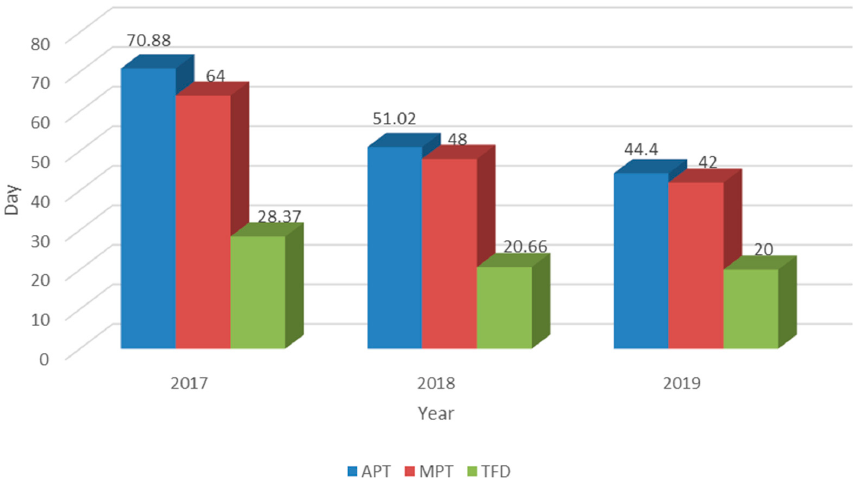
Figure 5. The average publication time (APT, blue), median publication time (MPT, red), and time from submission to first decision (TFD, green) in the past three years.